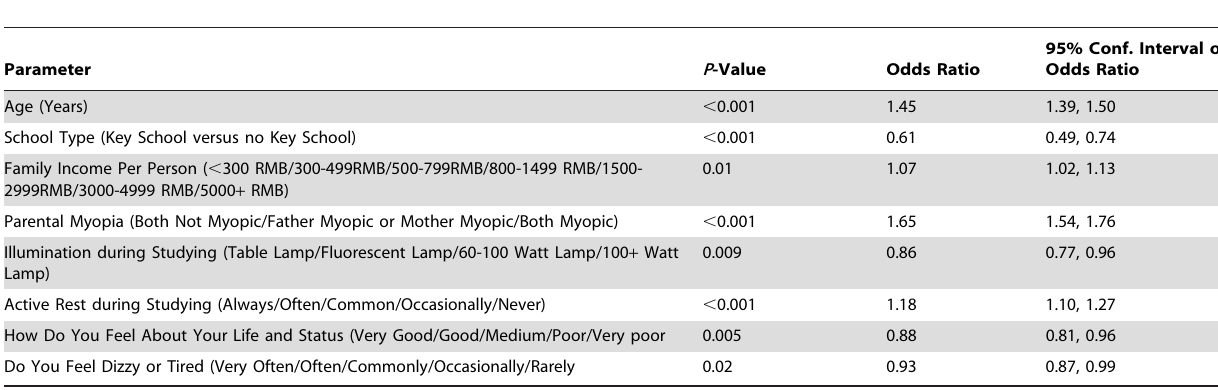
Table 5. Results of the multivariate analysis of the prevalence of myopia (defined as refractive error #2 6.00 diopters in the worse eye) and ocular and systemic parameters in the Beijing Pediatric Eye Study.